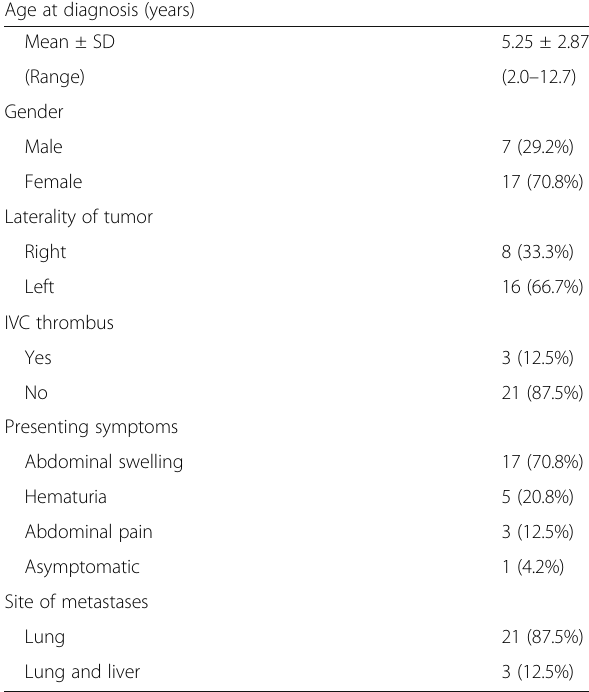
Table 1 Demographic data and clinical characteristics of the